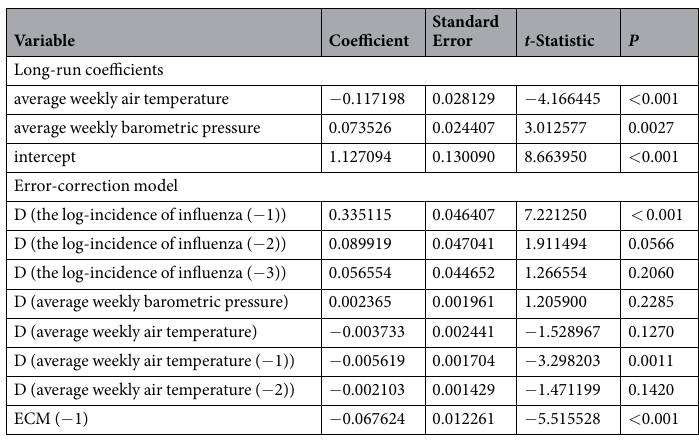
Table 3. Long-run coefficient and error-correction of the ARDL model.